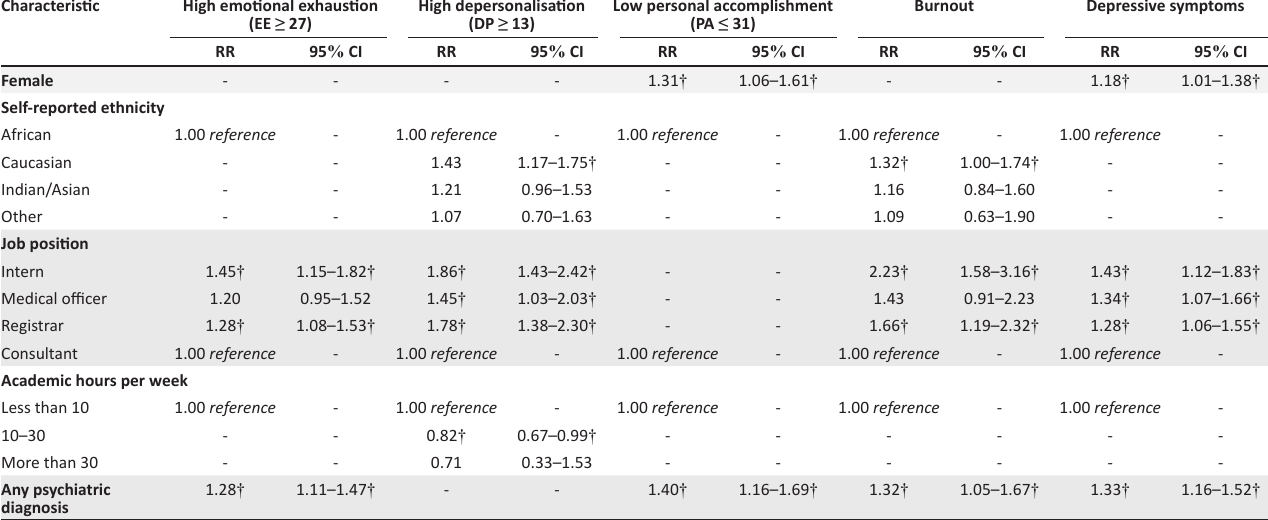
TABLE 4: Multivariable analysis of risk factors for burnout and depressive symptoms. Characteristic